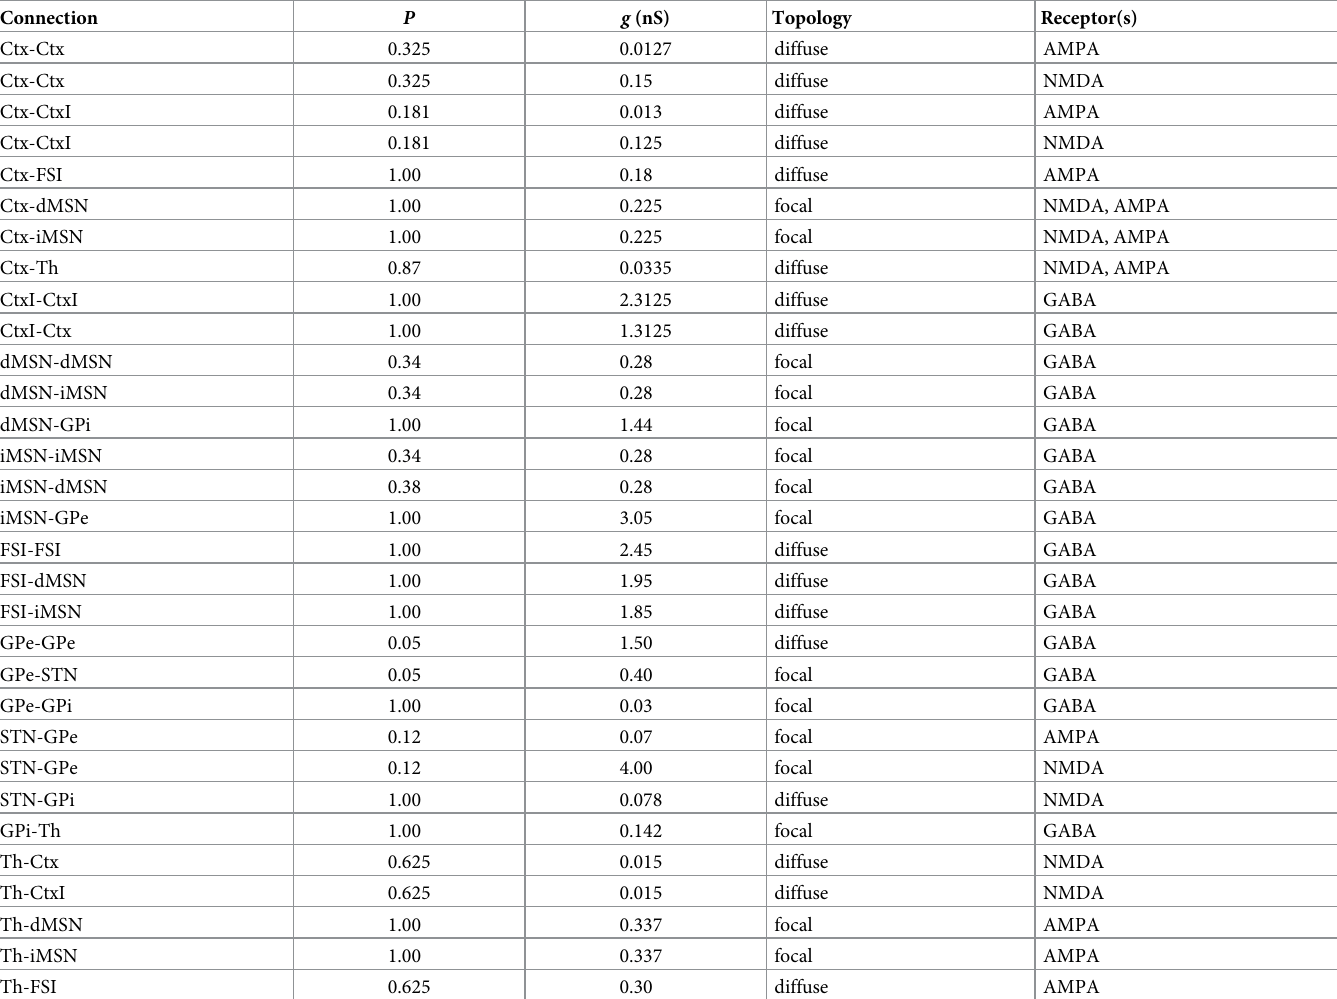
Table 3. Synaptic efficacy ( g ) and probability ( P ) of connections between populations in the CBGT network, as well as postsynaptic receptor types (AMPA, NMDA, and GABA). The topology of each connection is labeled as either diffuse, to denote connections with a P > 0 of projecting to left and right action channels, or focal, to denote connections that were restricted to within each